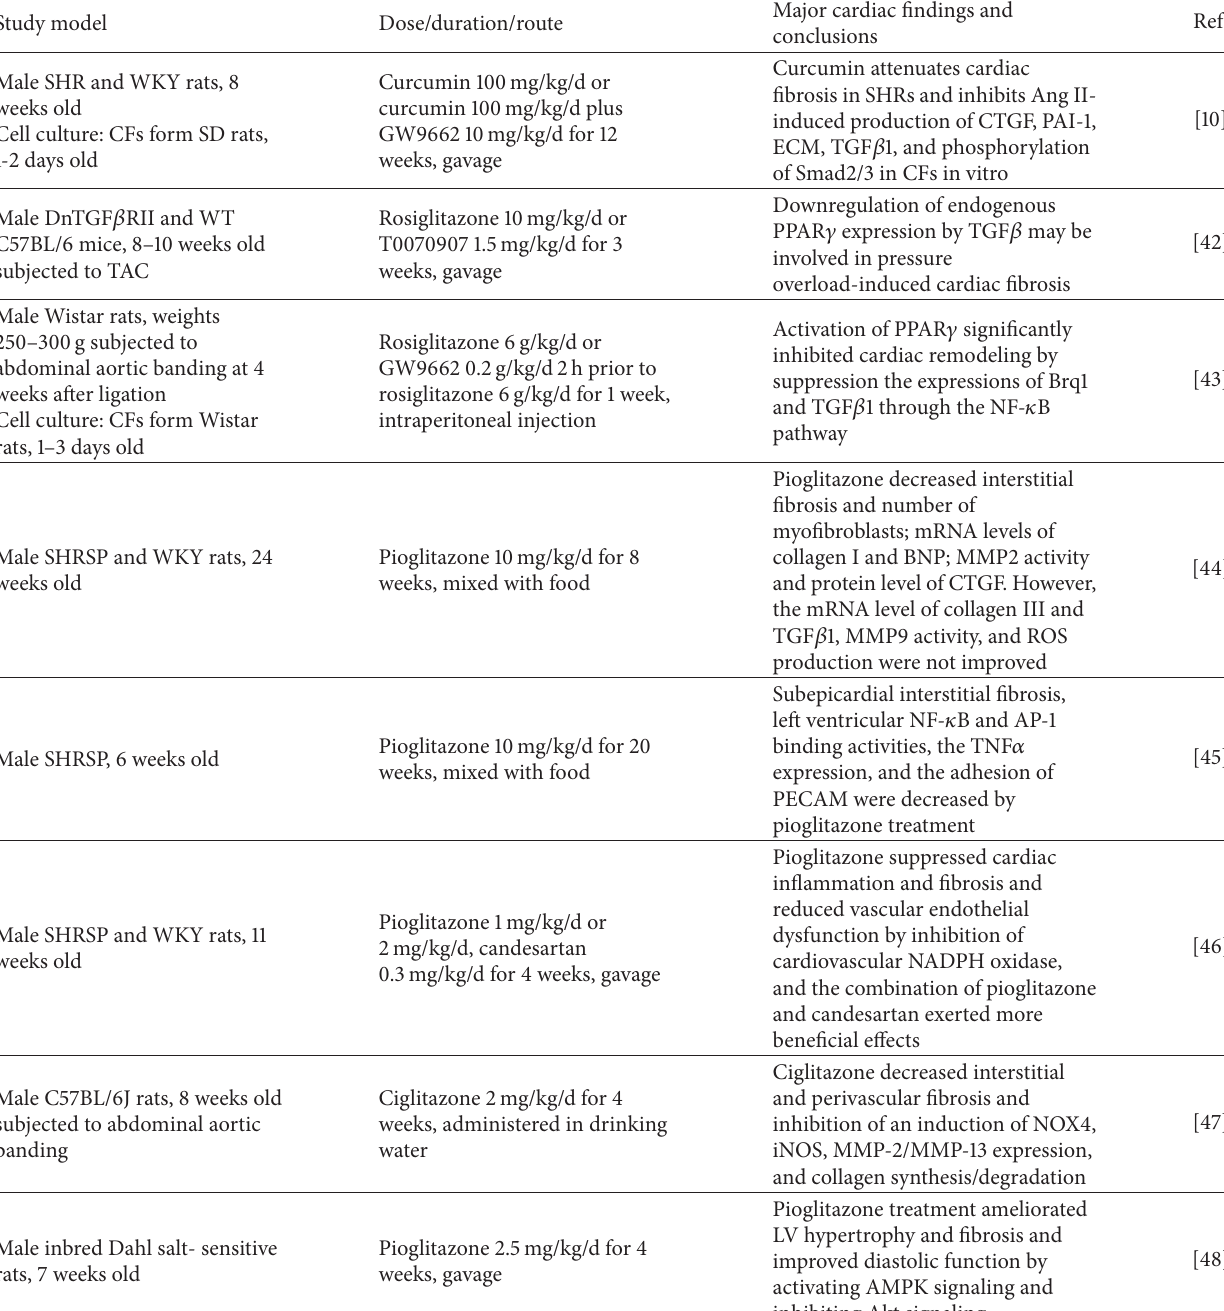
Table 3: Effects of PPAR 𝛾 ligands on hypertension related cardiac